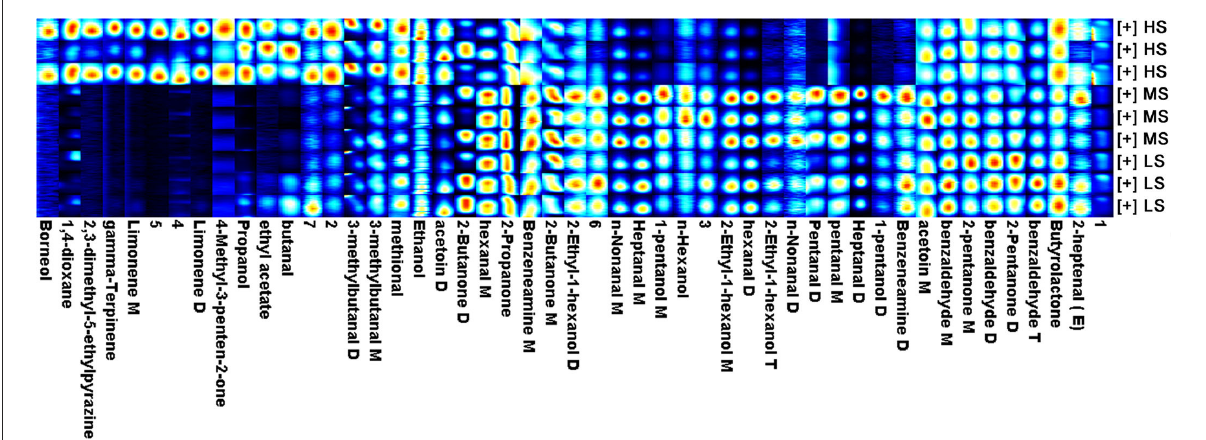
FIGURE1 The fingerprint of volatile flavor compounds obtained from the longissimus lumborum of Tibetan sheep under different energy level diets. M: monomer, D: dimer, T: polymer. 1–7 means unidentified compounds.